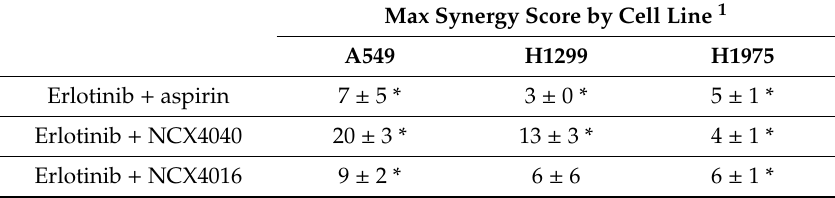
Table 3. Maximal synergy scores for the combination of erlotinib with aspirin, NCX4040, or NCX4016 in three NSCLC cell